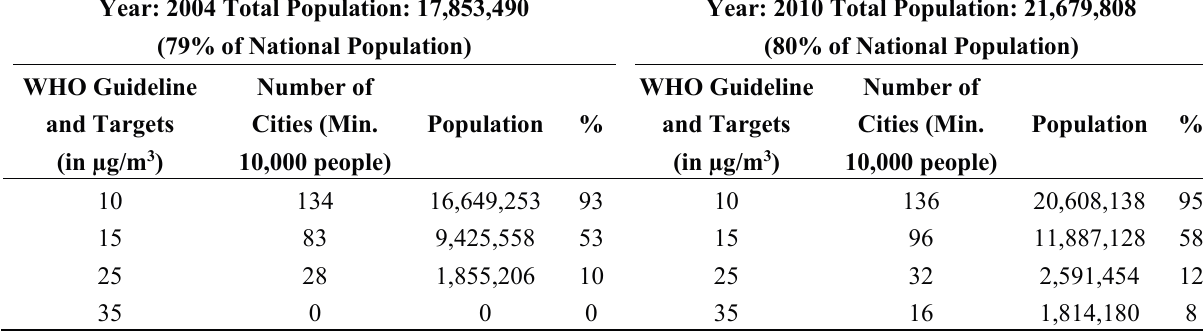
Table 1. Changes in population exposure to PM 2.5 concentrations (un-weighted) by WHO guidelines and targets.